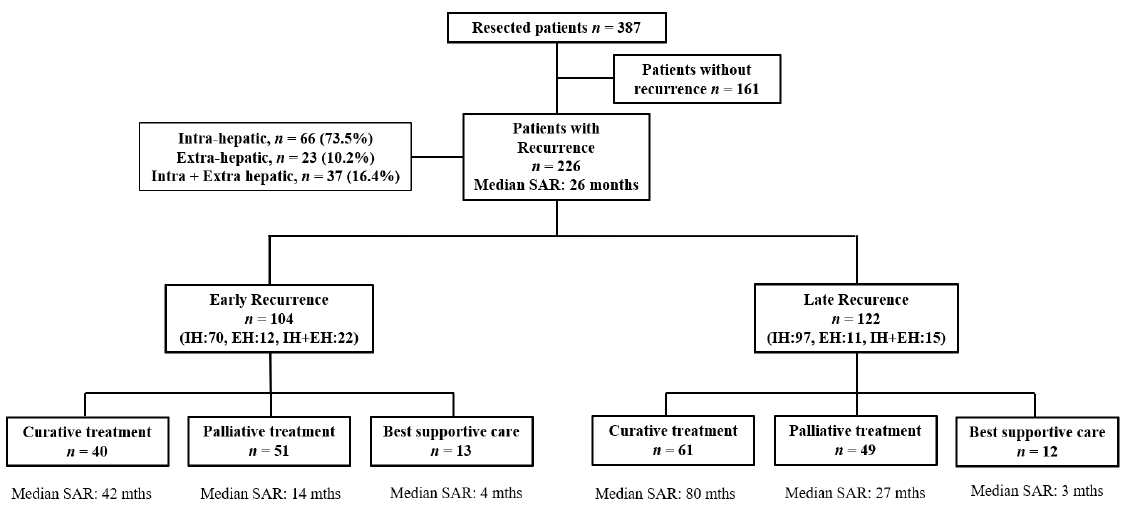
Figure 1. Flow chart of the study. SAR, Survival After Recurrence; IH, Intra-Hepatic; EH, Extra-Hepatic.